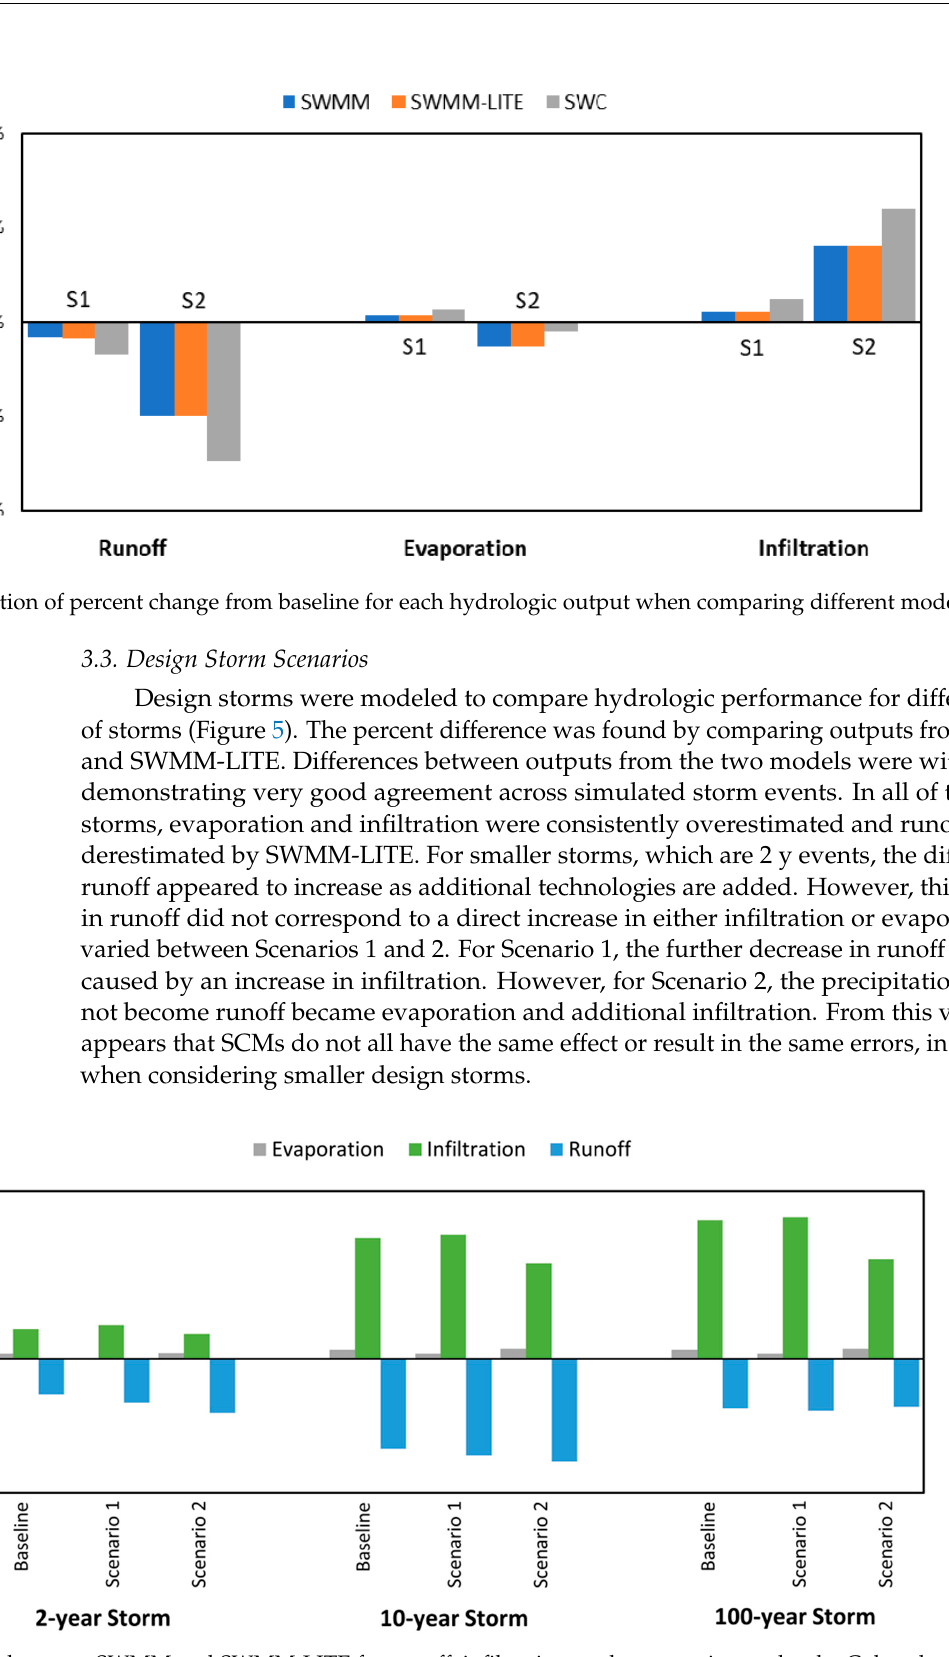
Figure 5. Difference between SWMM and SWMM-LITE for runoff, infiltration, and evaporation under the Colorado design storm modeling scenarios (positive values show a higher estimate from SWMM-LITE compared to SWMM and negative values show a lower estimate from SWMM-LITE compared to SWMM).